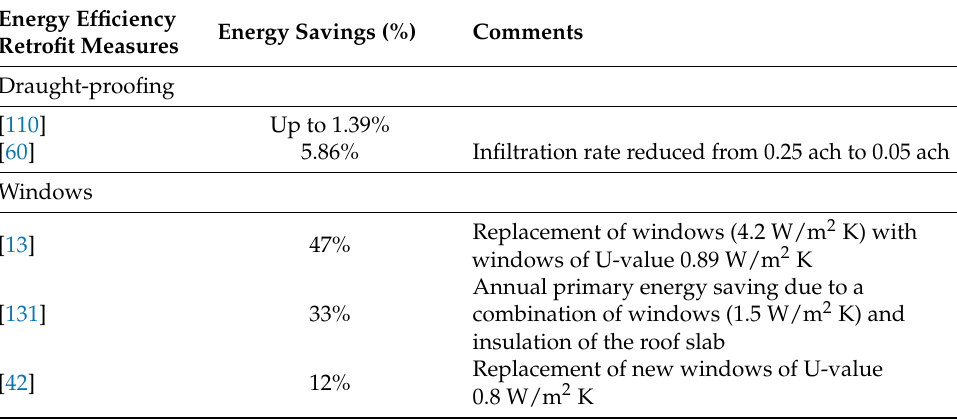
Table 1. Energy savings potentials from retrofits in heritage buildings reported in